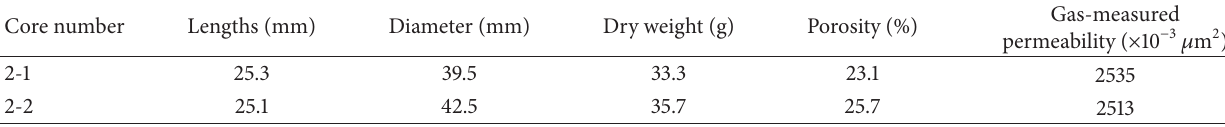
Table 2: Parameters of experimental cores.